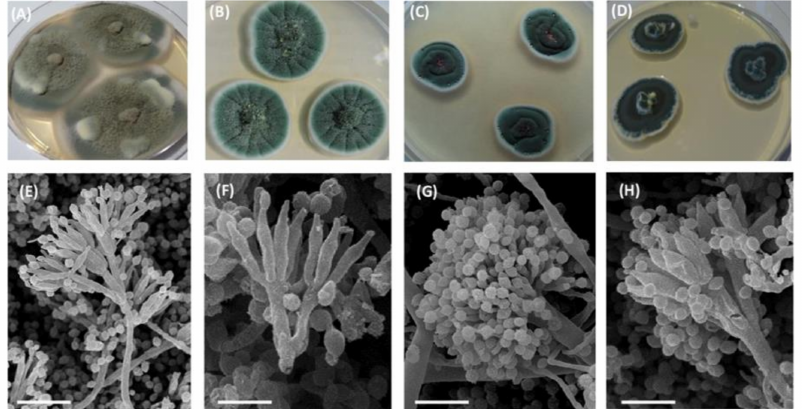
Figure 1. ( A – D ) Micromycete colonies on the solid culturing medium, seven days old. ( E – H ) Scan- ning electron images of micromycetes mycelium isolated from the TS-1 jet fuel. ( A , E ) Talaromyces amestolkiae , ( B , F ) Penicillium chrysogenum , ( C , G ) Aspergillus sydowii , and ( D , H ) Talaromyces rugulosus. Scale bar: ( F ) 5 µ m, ( E , G ) 10 µ m, and ( H ) 20 µ m.